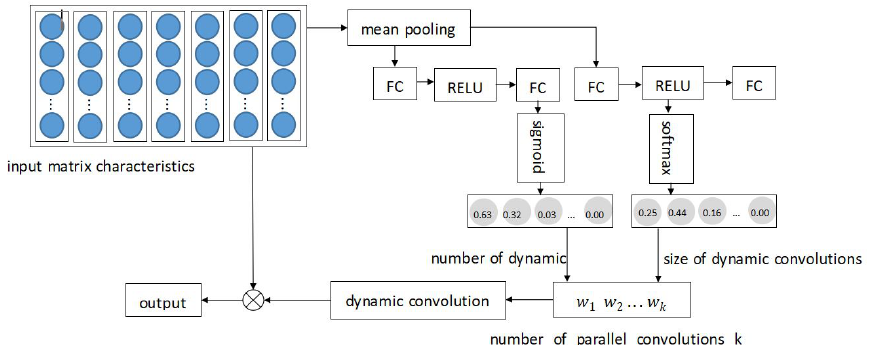
Figure 4. Dynamic CNN